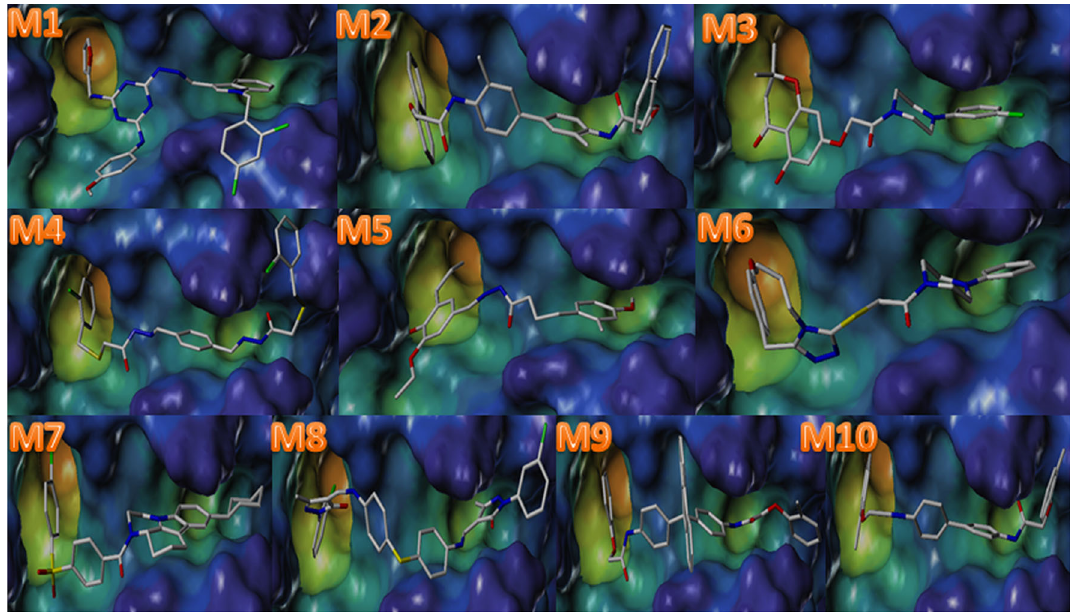
Fig. 4 The binding mode of hits with FXa carried out by SYBYL. Grey sticks were represented the ligand , and blue and green represented active cave